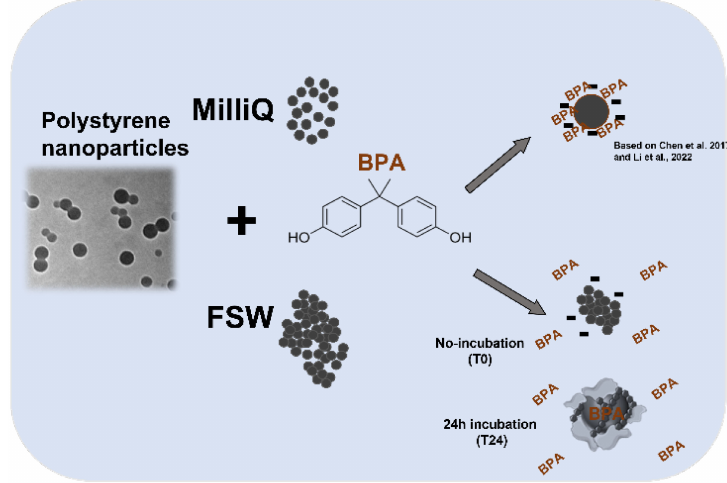
Figure 5. A diagram showing the possible interaction between PS NPs and BPA in MilliQ and FSW based on DLS data and biological findings. Refer to Chen et al., 2017 and Li et al., 2022